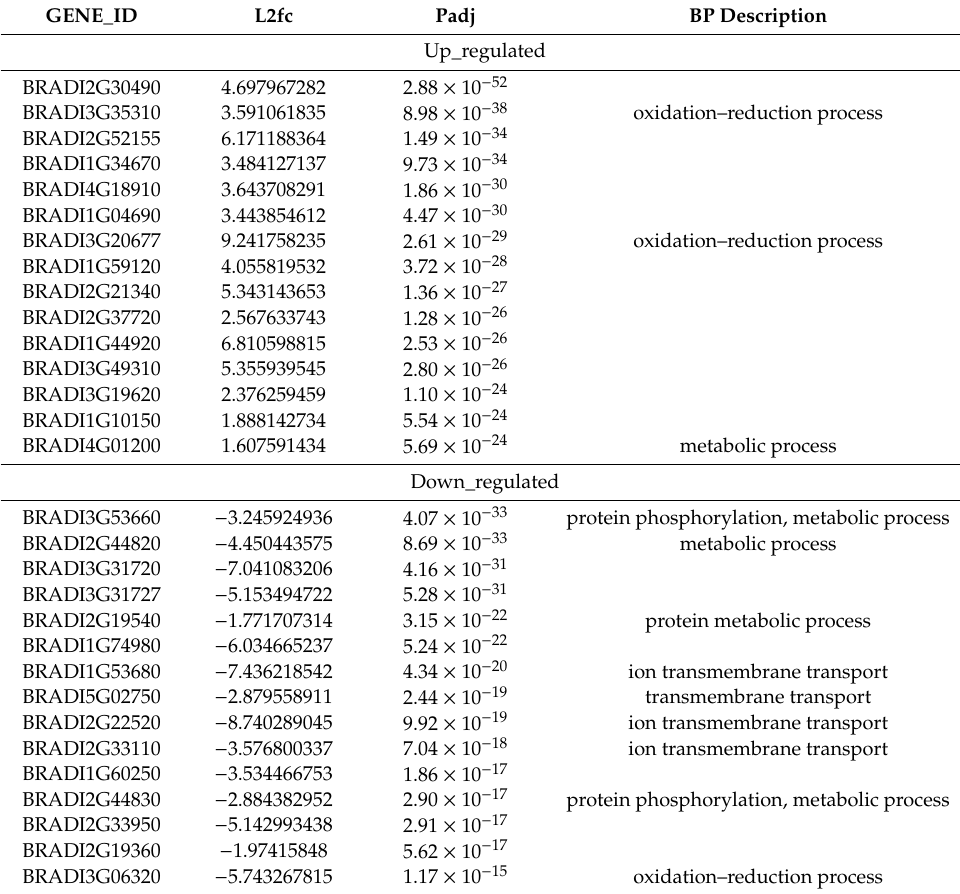
Figure 2. ( A ) 3-week-old seedlings of B. distachyon ; the left picture was the control and the right picture was the treatment with 200 mM NaCl for 24 h. ( B ) Expression patterns of DEGs identified between 200 mM NaCl treatment group and control group. SALT_S indicated that cells were exposed to 200 mM NaCl for 24 h; CK_S indicated that cells were cultured under the control condition. Red and green dots represent DEGs, and blue dots indicate genes that were not differentially expressed. Table 2. The top 30 dysregulated genes in B. distachyon under 200 mM NaCl treated and control conditions.